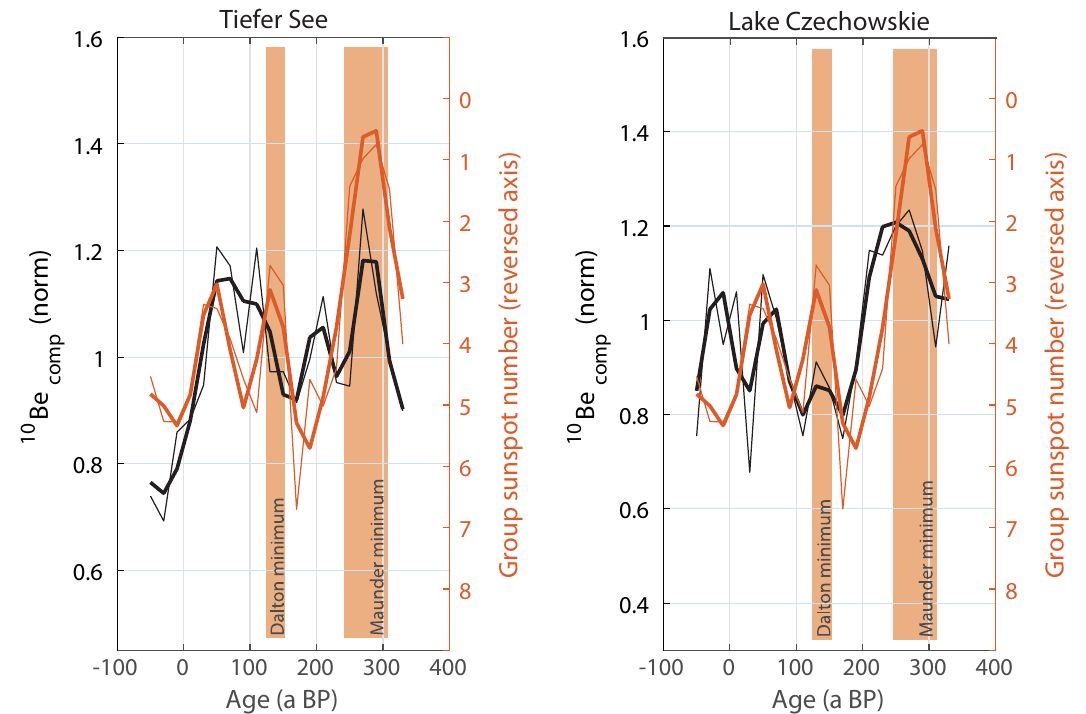
Figure 5. 10 Be composites ( 10 Be comp ) from Tiefer See (TSK) and Lake Czechowskie (JC) compared with group sunspot numbers back to 340aBP (Svalgaard and Schatten, 2016). Time windows of the Maunder and Dalton solar minima are highlighted (Eddy, 1976; Frick et al., 1997). Time series are shown at 20-year resolution (thin lines) and with a 75-year low-pass filter, to reduce noise (thick lines). 10 Be comp records were normalized by dividing by the